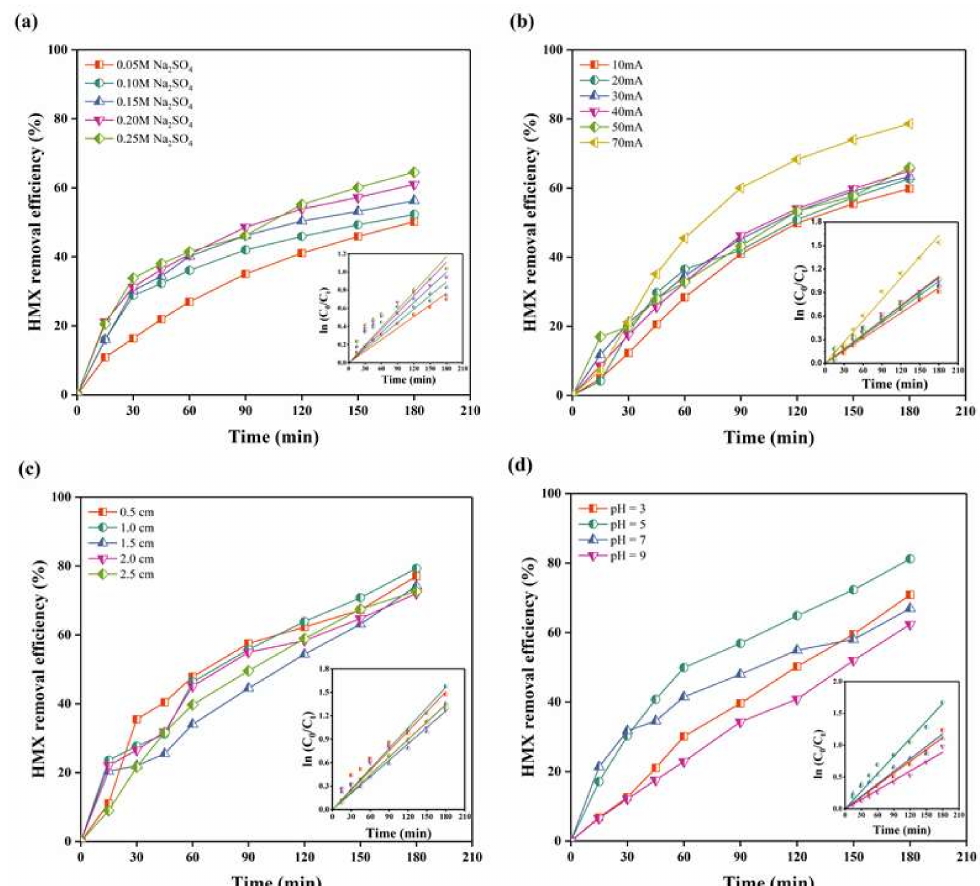
Figure 1. The effects of different operating parameters on HMX removal efficiency. ( a ) Electrolyte concentrations; ( b ) current densities; ( c ) electrode distance; ( d ) initial pH. The inset plot depicts corresponding pseudo-first-order